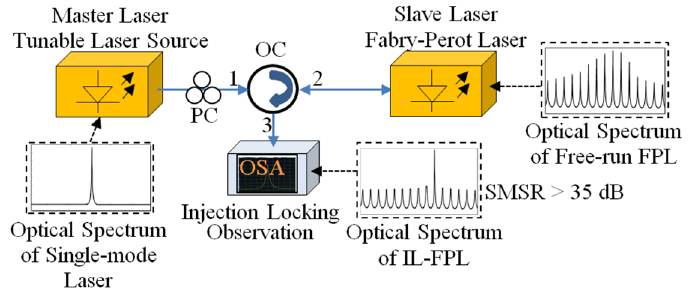
Figure 5. Schematic of experimental set-up for observing IL in optical domain.